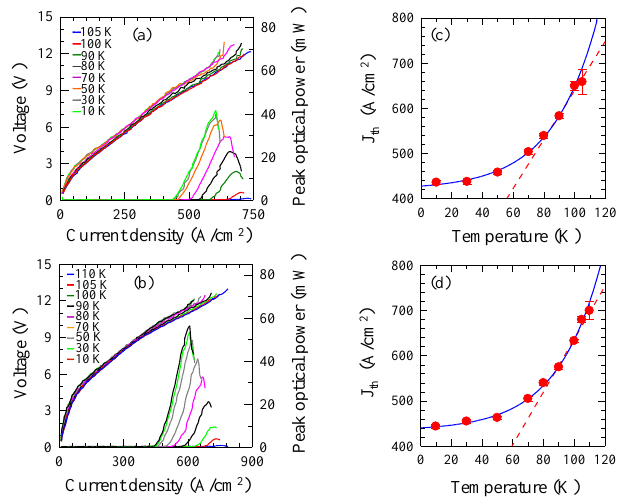
Figure 7. ( a , b ) Far-field emission patterns of the ( a ) type A (FF = 26.8%, a = 32.5 μm) and ( b ) type B (FF = 25%, a = 30 μm) obtained by scanning a pyroelectric detector at a distance of about 5 cm distance from the device surface.